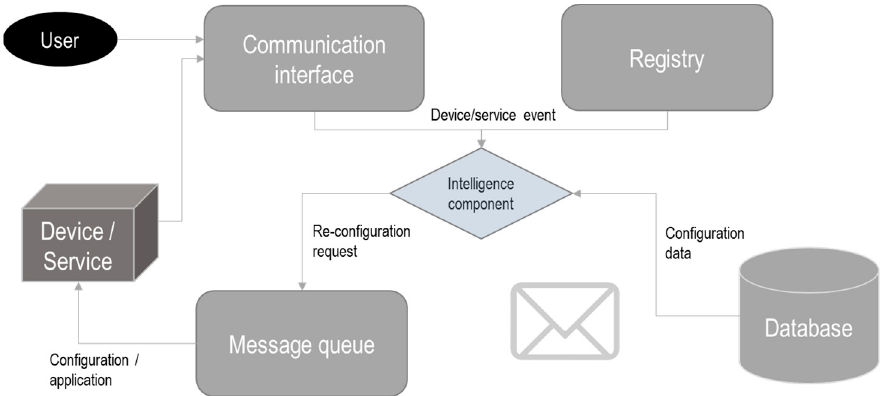
Figure 8. A self-configuration structure, as per enablers described in ASSIST-IoT. Source: the authors’ own diagram, based on [73].